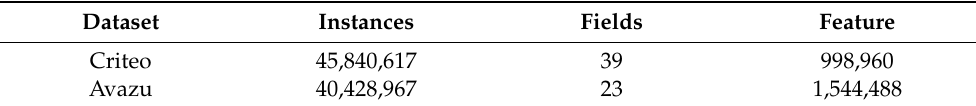
Table 1. Dataset